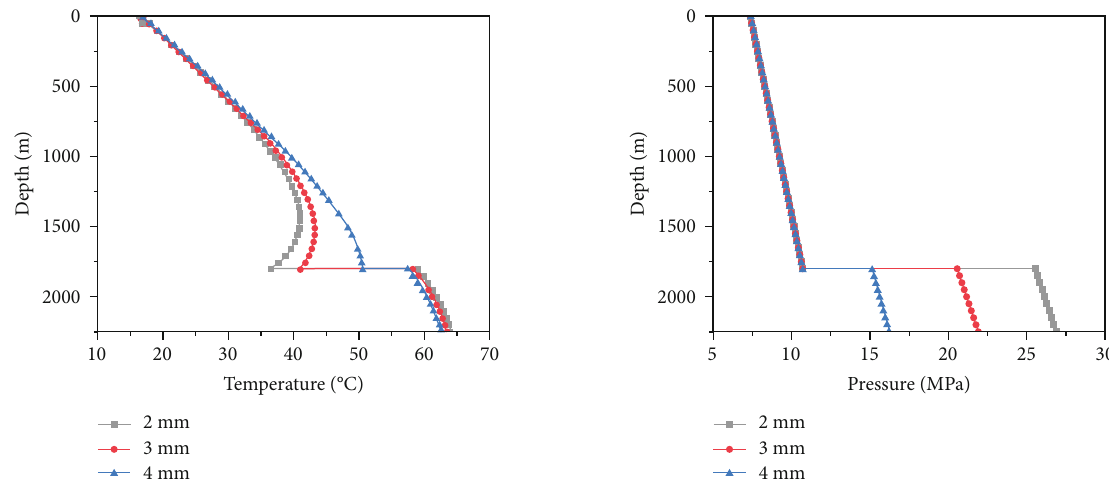
Figure 8: E ff ect of throttle nozzle diameter on throttle temperature and pressure distribution.